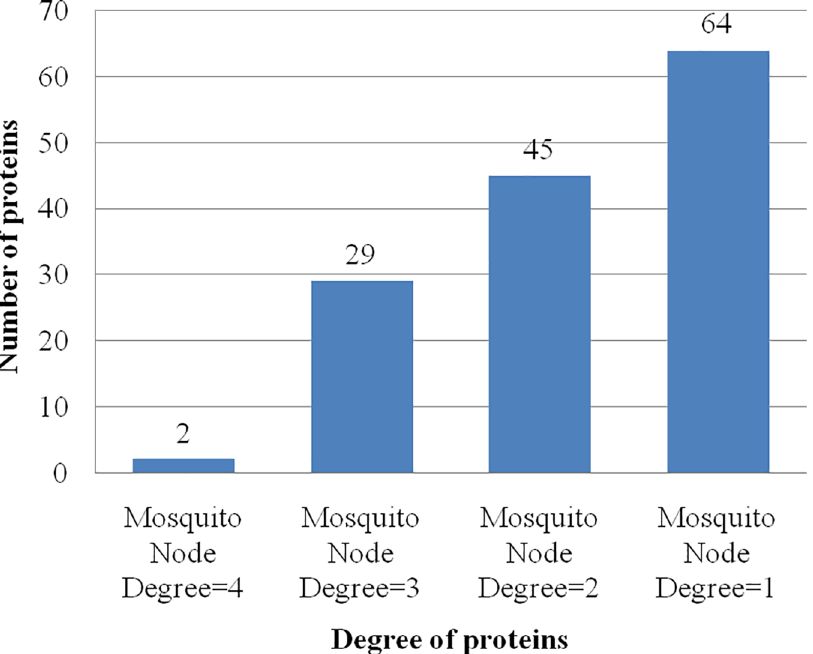
Fig 6. Average degree distribution of mosquito protein nodes in dengue–mosquito PPI network. It can be noted from the figure that at mosquitonode degree= 1, there is a maximum number (64) of interactions, and at humannode degree= 4, there are only 2 interactions. Therefore, most of the mosquitoproteinsinteract with 1 dengueprotein, and a majority of mosquitoproteinsparticipatein a few interactions. PPI, protein– protein interactions.